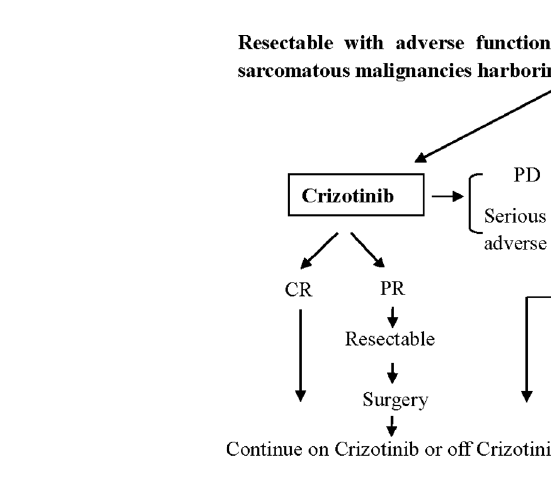
FIGURE 3 | Proposed clinical routine for the treatment of metastatic ALK-positive sarcomatous malignancies. PD, progressive disease; CR, complete remission; PR, partial